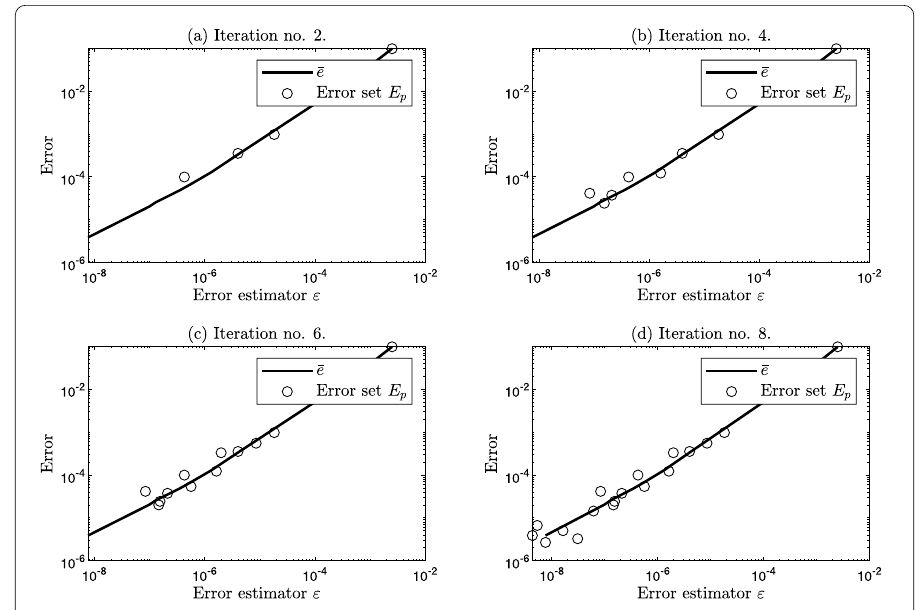
Figure 8 Error model ¯ e based on error set E p for four different greedy iterations